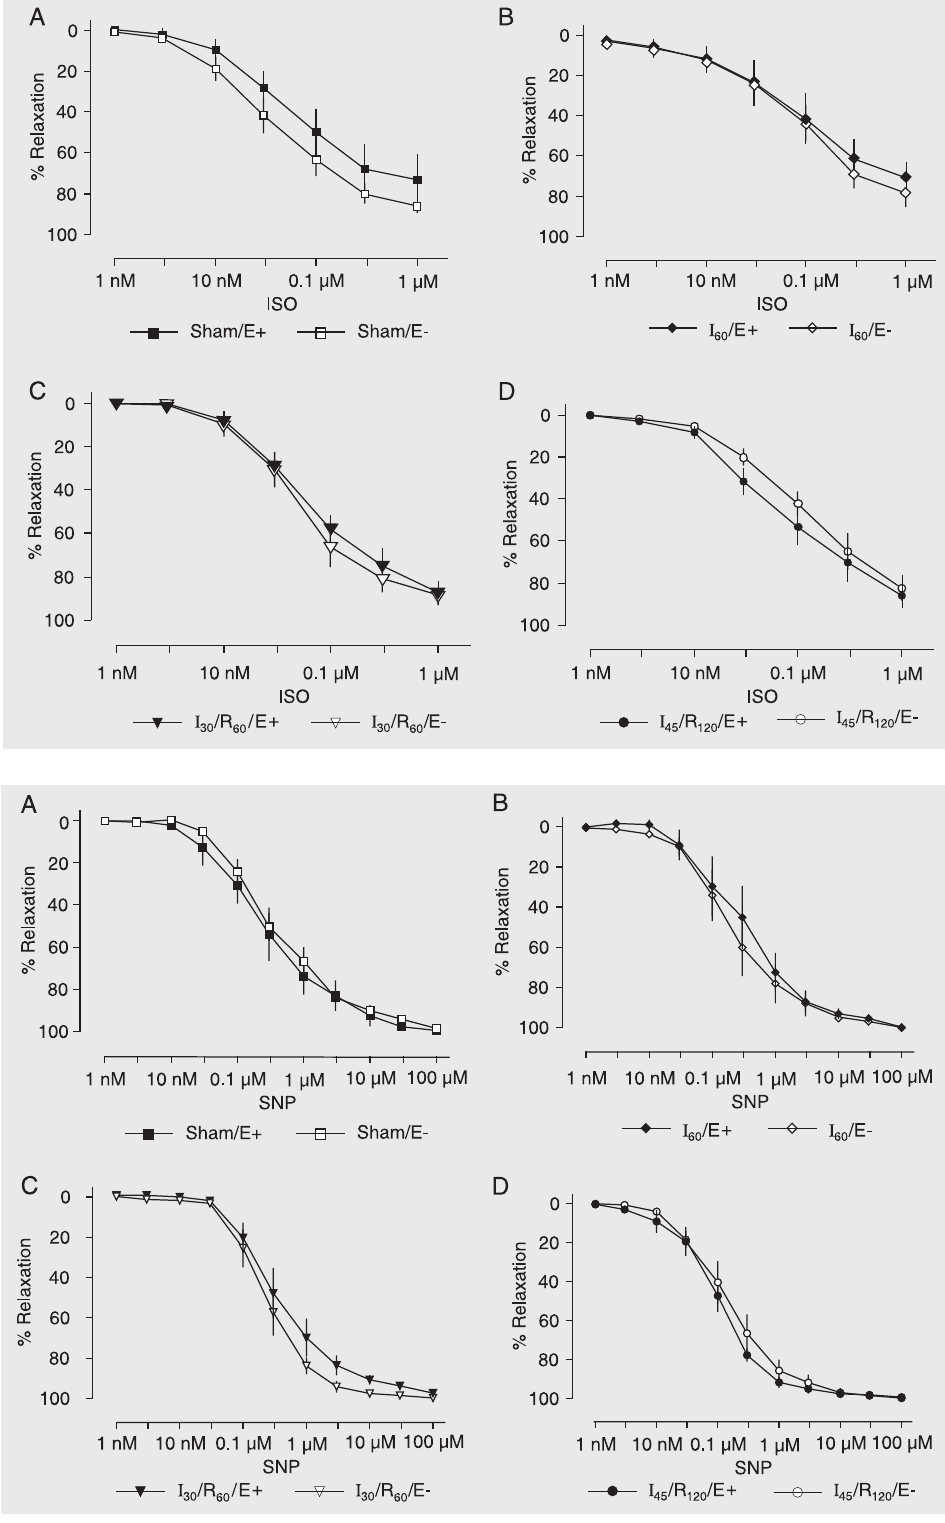
Figure 5. Concentration-re- sponse curves to isoproterenol (ISO, 1 nM to 1 µM) by hepatic artery smooth muscle. Hepatic artery segments were exposed to sham operation (Sham, A), 60 min of ischemia (I 60 , B), 30 min of ischemia followed by 60 min of reperfusion (I 30 /R 60 , C), and 45 min of ischemia followed by 120 min of reperfusion (I 45 /R 120 , D) with (E+) and without endo- thelium (E-). Data are reported as means ± SEM, N = 6 per group. Arterial segments were first contracted with prostaglan- din F 2 α and exposed to increas- ing drug concentrations. No sig- nificant difference was found among groups (ANOVA).